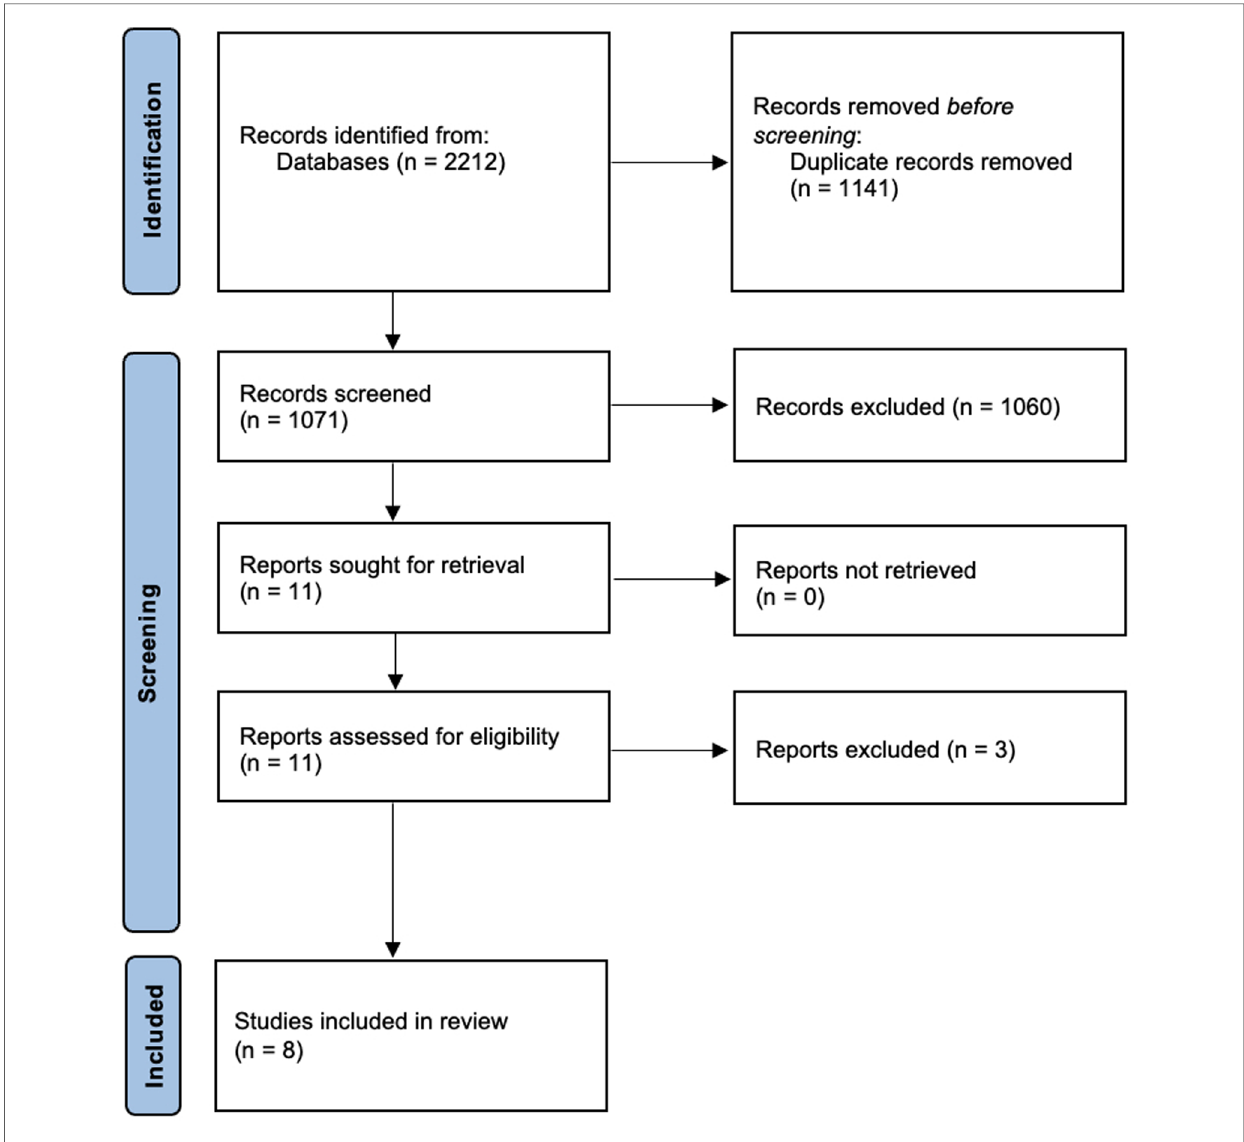
FIGURE 1 The PRISMA diagram reporting the results of our search and screening